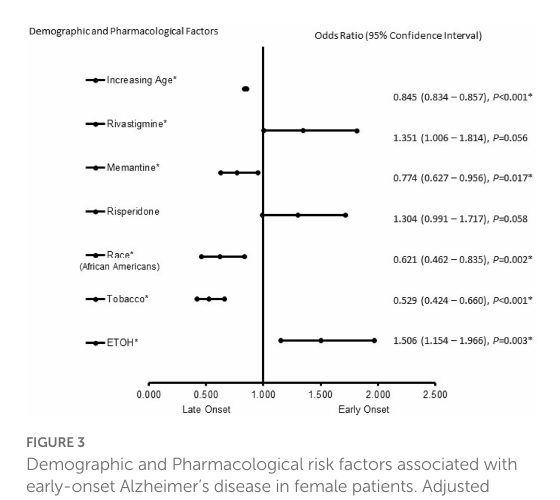
FIGURE 1 Demographic and pharmacological factors associated with early onset Alzheimer’s disease compared to late-onset Alzheimer’s disease independent of biological sex. Adjusted OR < 1 denotes factors that are associated with a late onset, while OR > 1 denotes factors that are associated without an early onset. Hosmer- Lemeshow test ( p < 0.001*), Cox & Snell ( R 2 = 0.148). The overall classified percentage of 93.4% was applied to check for the fitness of the regression model. *Indicates statistical significance ( p < 0.05) with a 95% confidence